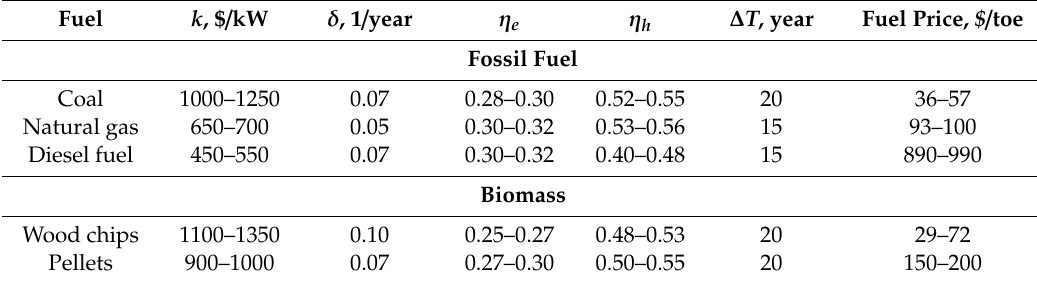
Table 4. Technical and economic indicators of power plants on different types of fuel (cogeneration of electricity and heat).